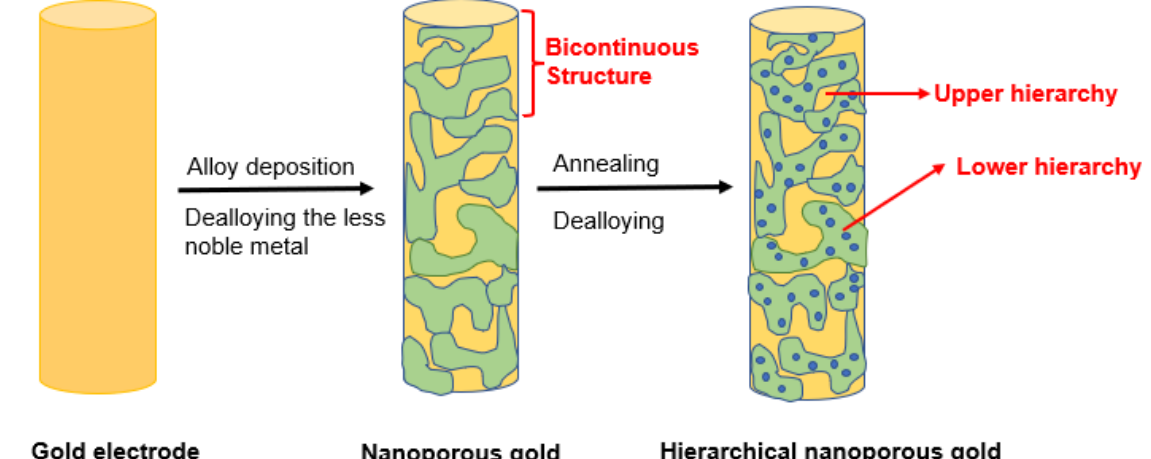
Figure 3. Depiction of the common route used to create upper and lower hierarchy in a material.